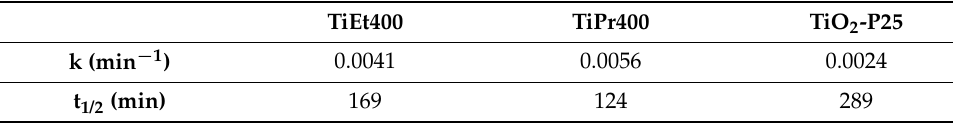
Table 2. Kinetic